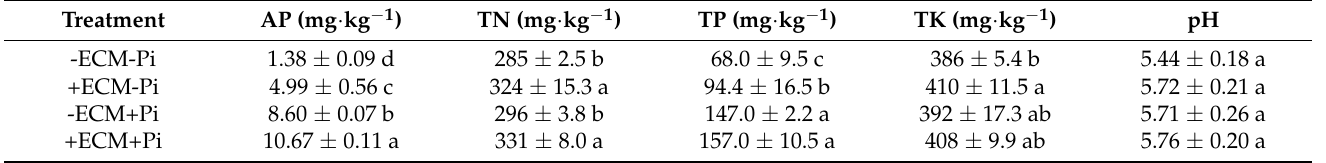
Table 2. Influence of ECMF and Pi levels on the chemical properties of the rhizosphere soil. Treatment